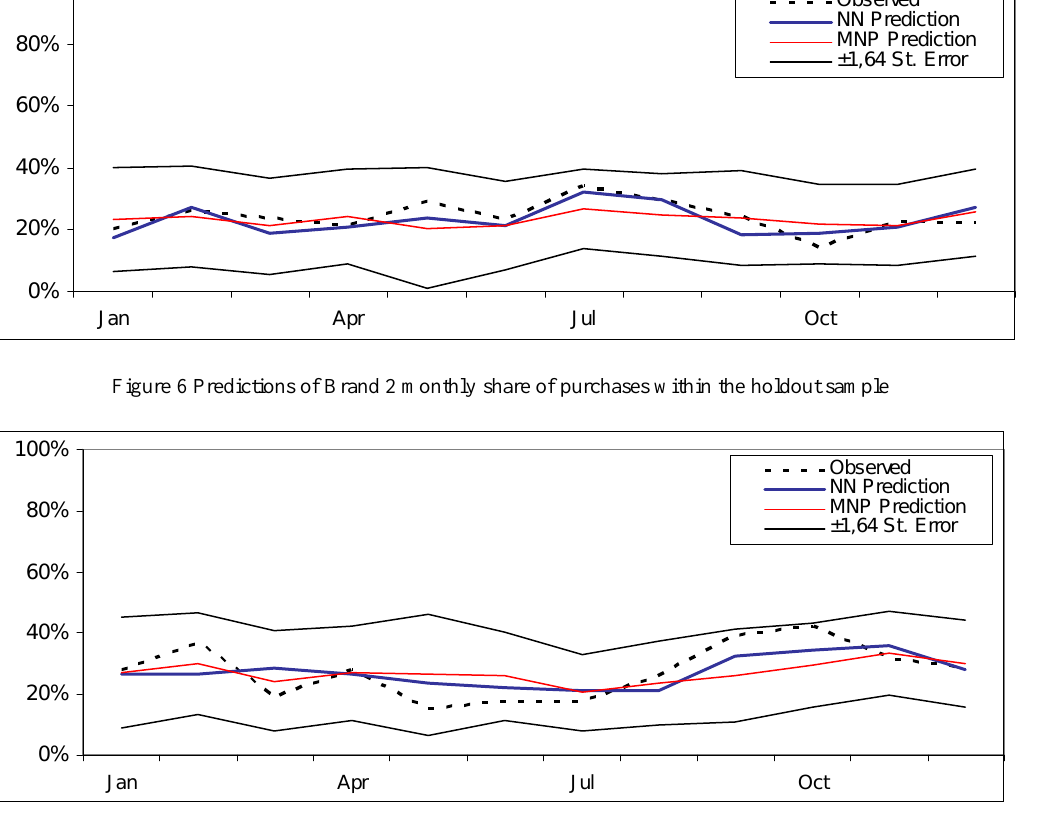
Figure 7 Predictions of Brand 3 monthly share of purchases within the holdout sample